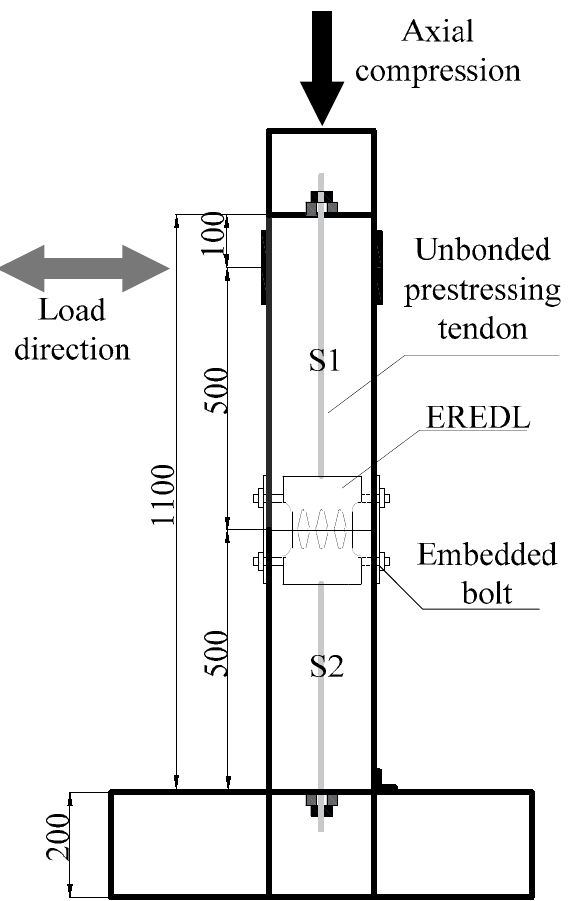
Figure 1. Construction of segmental assembled PSCFET bridge pier specimens.